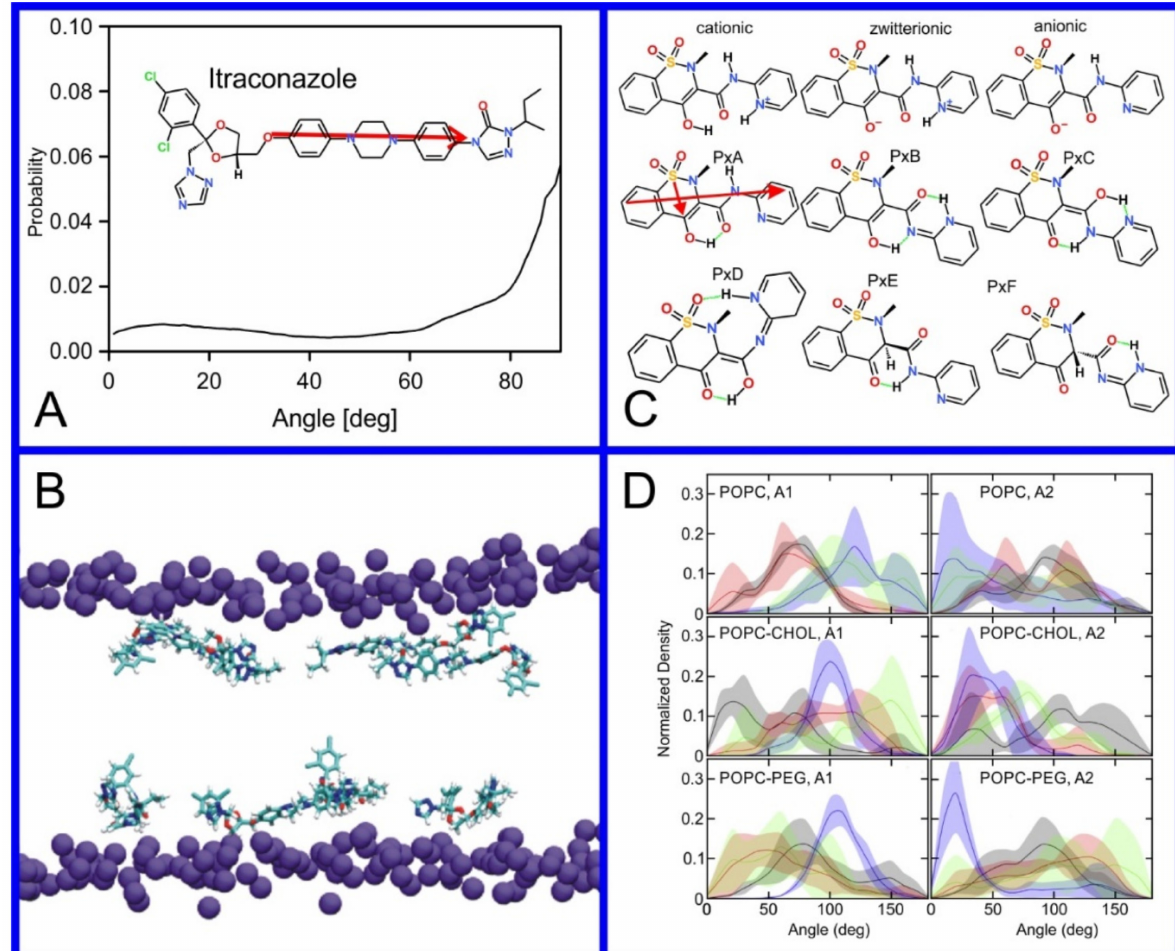
Figure 8. ( A ) Distribution of values of the angle between the vector representing the itraconazole long axis (red arrow at the chemical structure of itraconazole) and the bilayer normal [184]. ( B ) Snapshot showing itraconazole molecules in a lipid bilayer, purple spheres are phosphate groups of the POPC molecules [184]. ( C ) Chemical structures of piroxicam tautomers. ( D ) Distribution of angles between the vector representing the piroxicam long and short axes (red arrows at the chemical structure of PxA) and bilayer normal; PxA—black line, PxE—read line, zwitterionic—green line, cationic—blue line